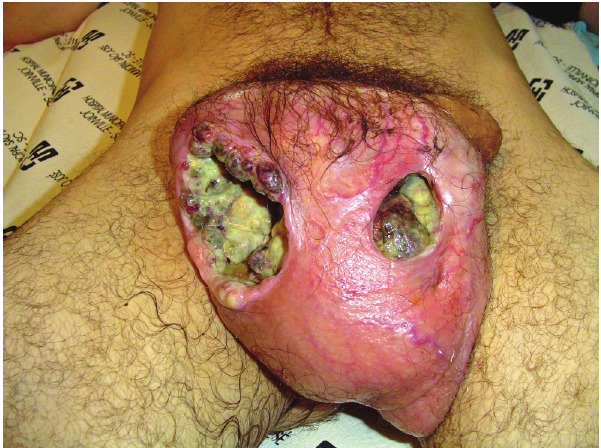
Figure 1 - Extensive necrosis on the right hemiscrotum